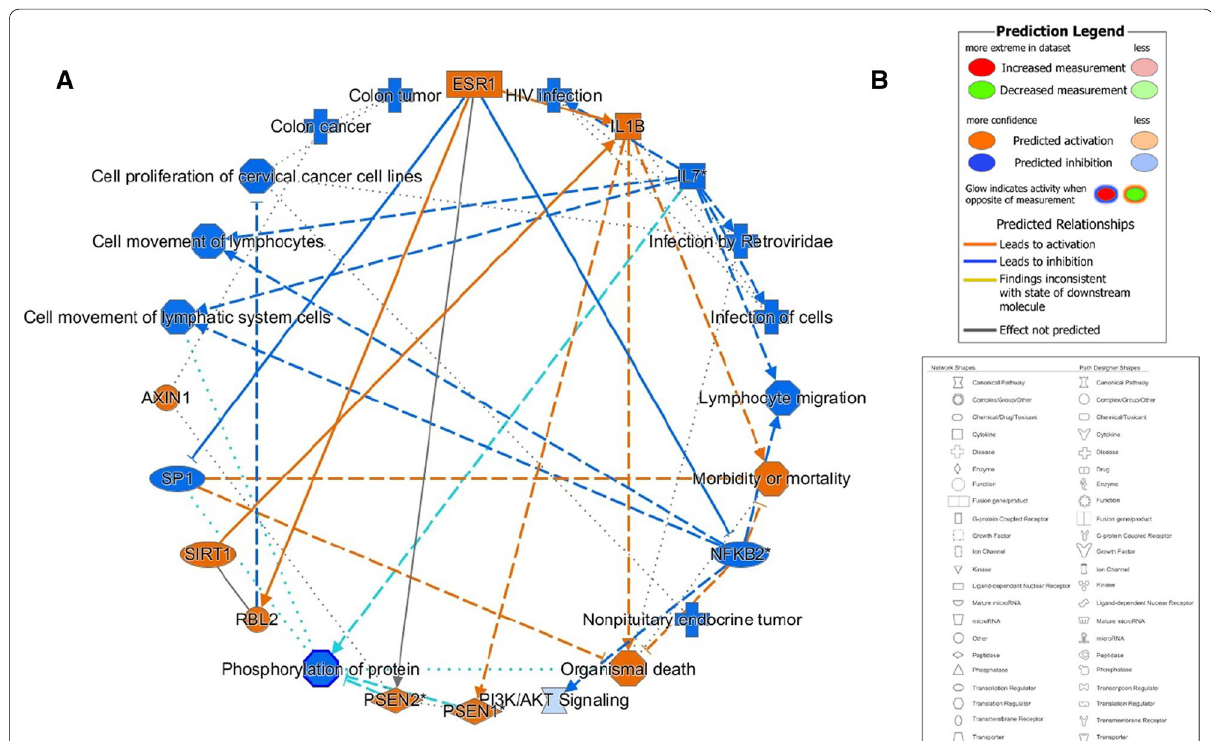
Fig. 1 A Graphical summary and B Different shapes represent the molecular class of the protein. Blue and orange indicate inhibition and activation. A solid line indicates a direct interaction, a dashed line indicates an indirect interaction, and a dotted line indicates inferred correlation from machine-based learning. An asterisk indicates that multiple identifiers in the dataset file map to a single gene or chemical in the Global Molecular